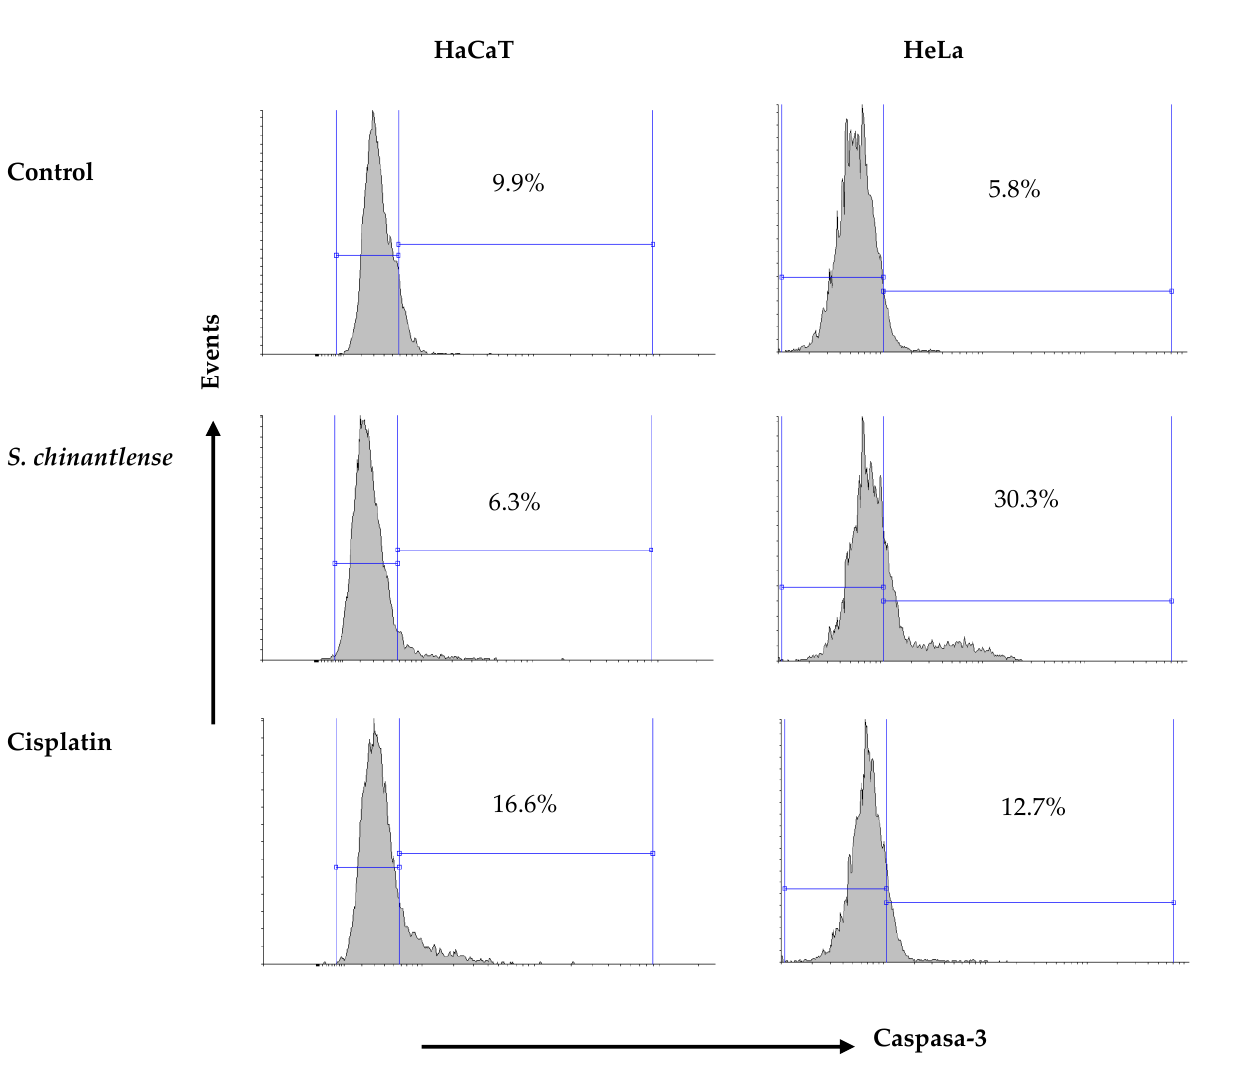
Figure 6. Activation of caspase-3 in HeLa and HaCaT cell lines after incubation with S. chinantlense extract or cisplatin at the IC 50 value for 48 h.